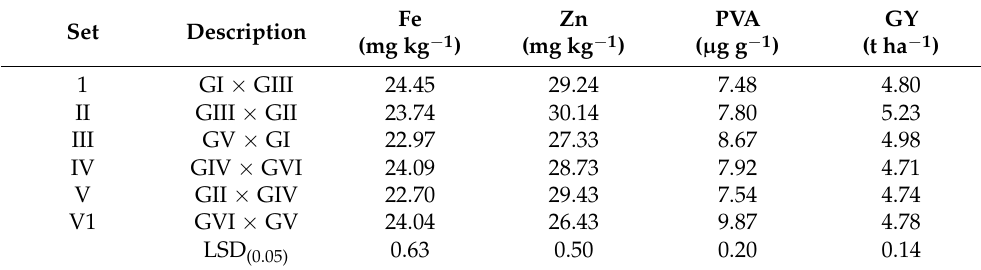
Table 6. Mean values for Zn, Fe, PVA contents and grain yield for the six mating sets across